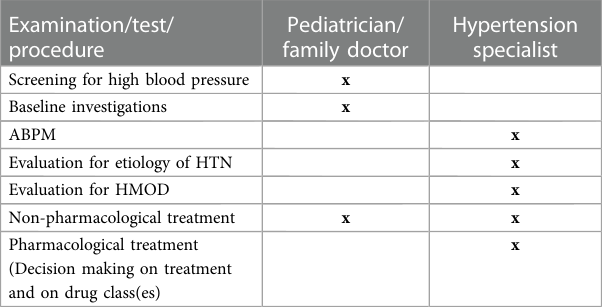
TABLE 13 Recommended responsibility for hypertension work-up and management in children and